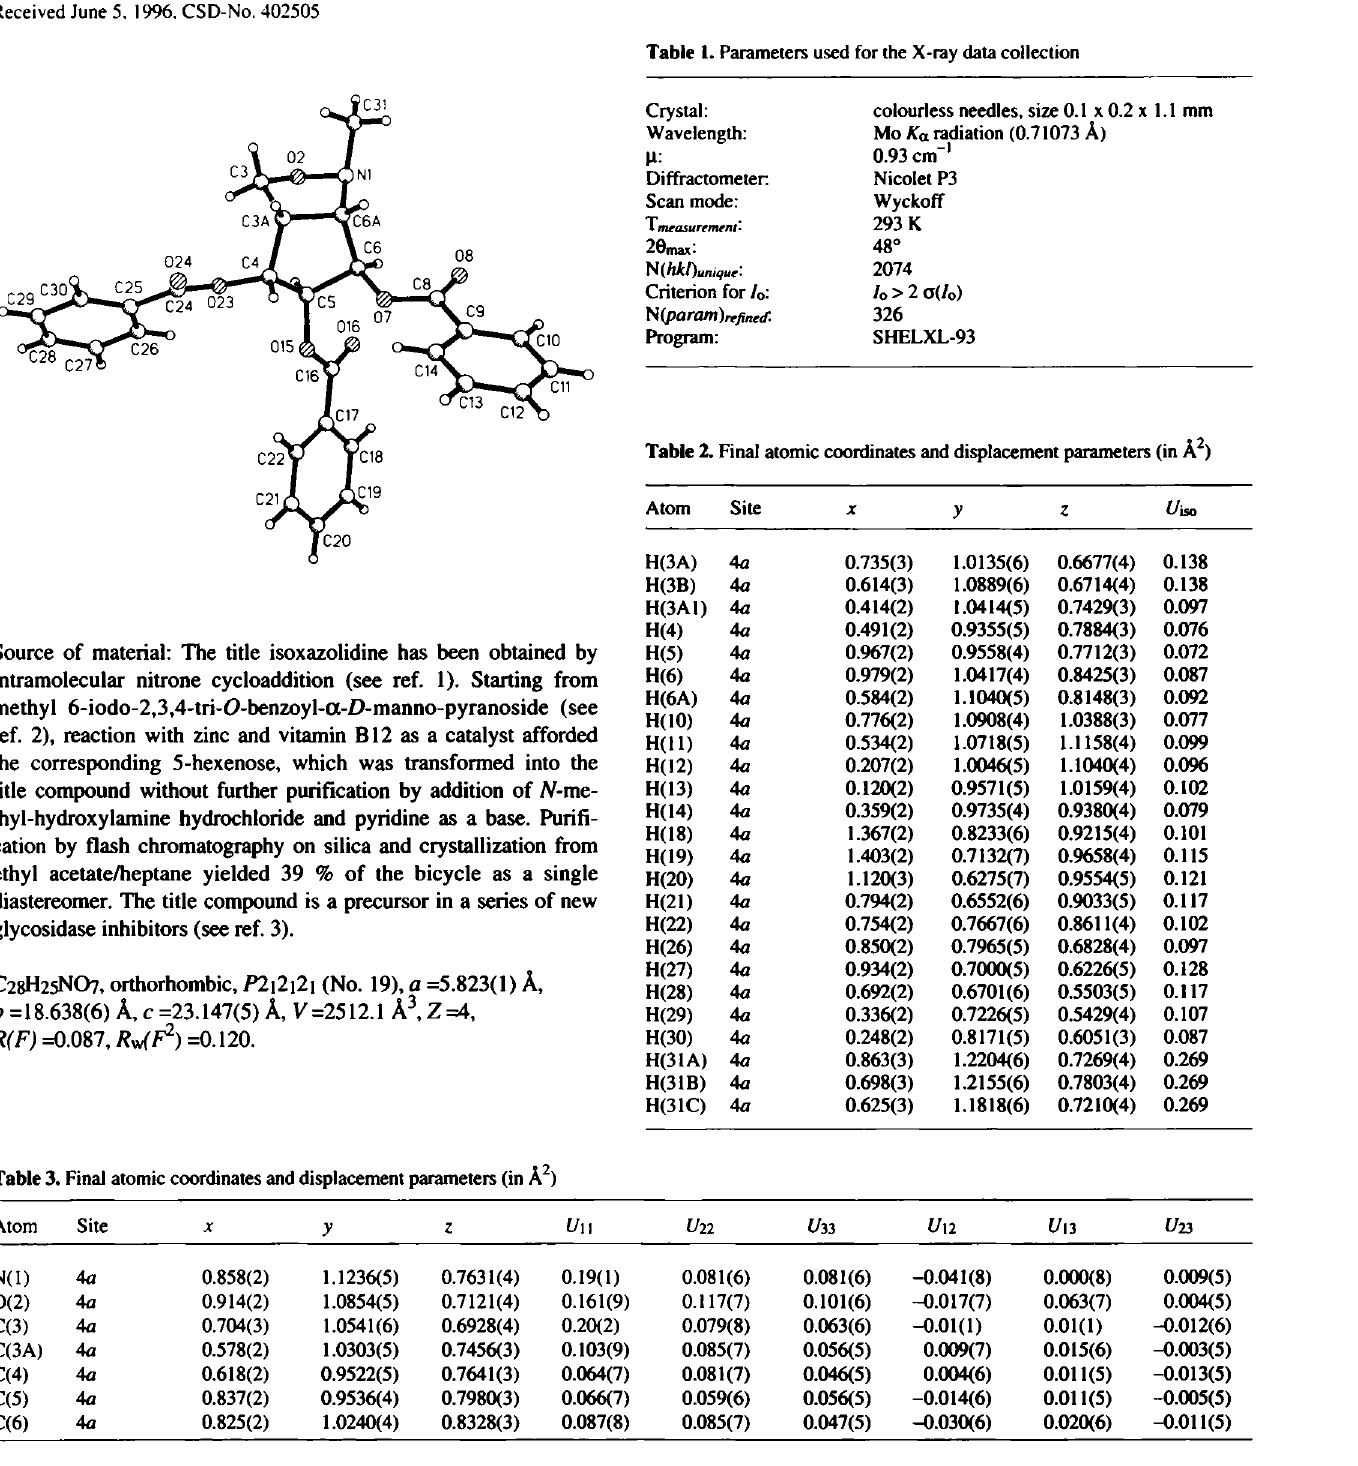
Table 2. Final atomic coordinates and displacement parameters (in Â 2 )